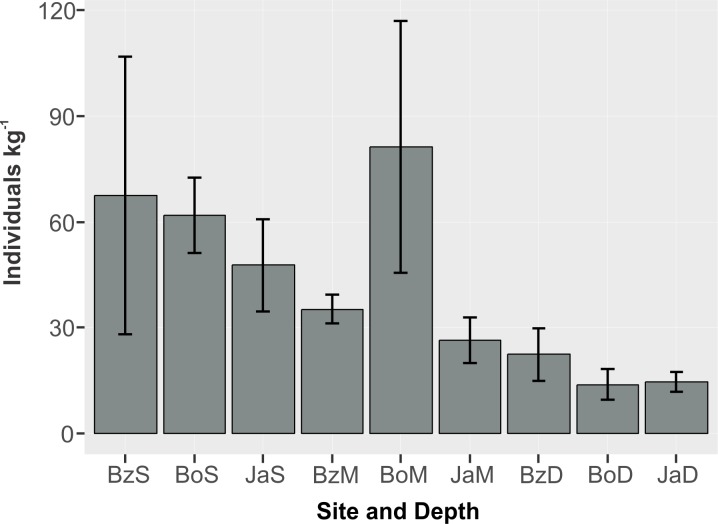
Abundance (individuals kg−1) (mean and standard error) of cryptic peracarids in coral rubble in three depths (S = shallow back-reef (3 m), M = intermediate depth fore-reef (6–8 m), D = deep fore-reef (10–12 m) of three reef sites (Bz: Bonanza, Bo = Bocana, Ja = Jardines) within the Puerto Morelos Reef National Park.